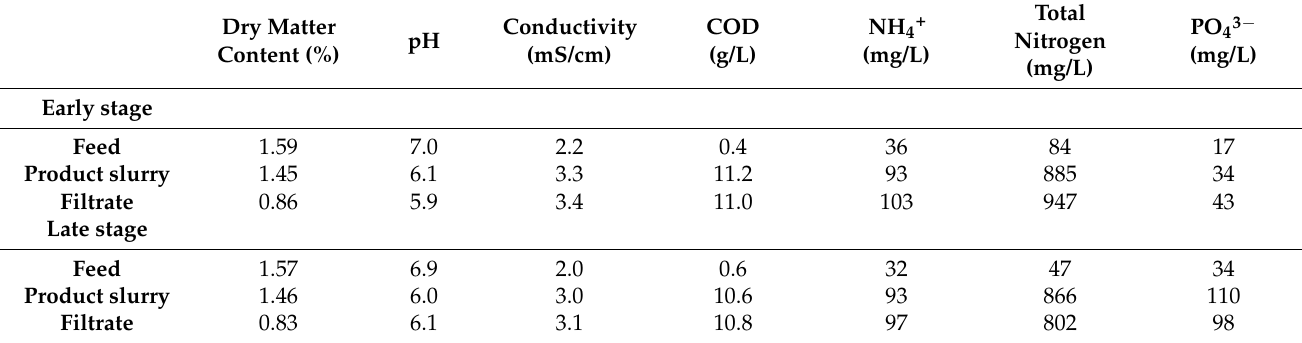
Table 6. Characteristics of the bio-sludge feed, product slurry and filtrate obtained with the